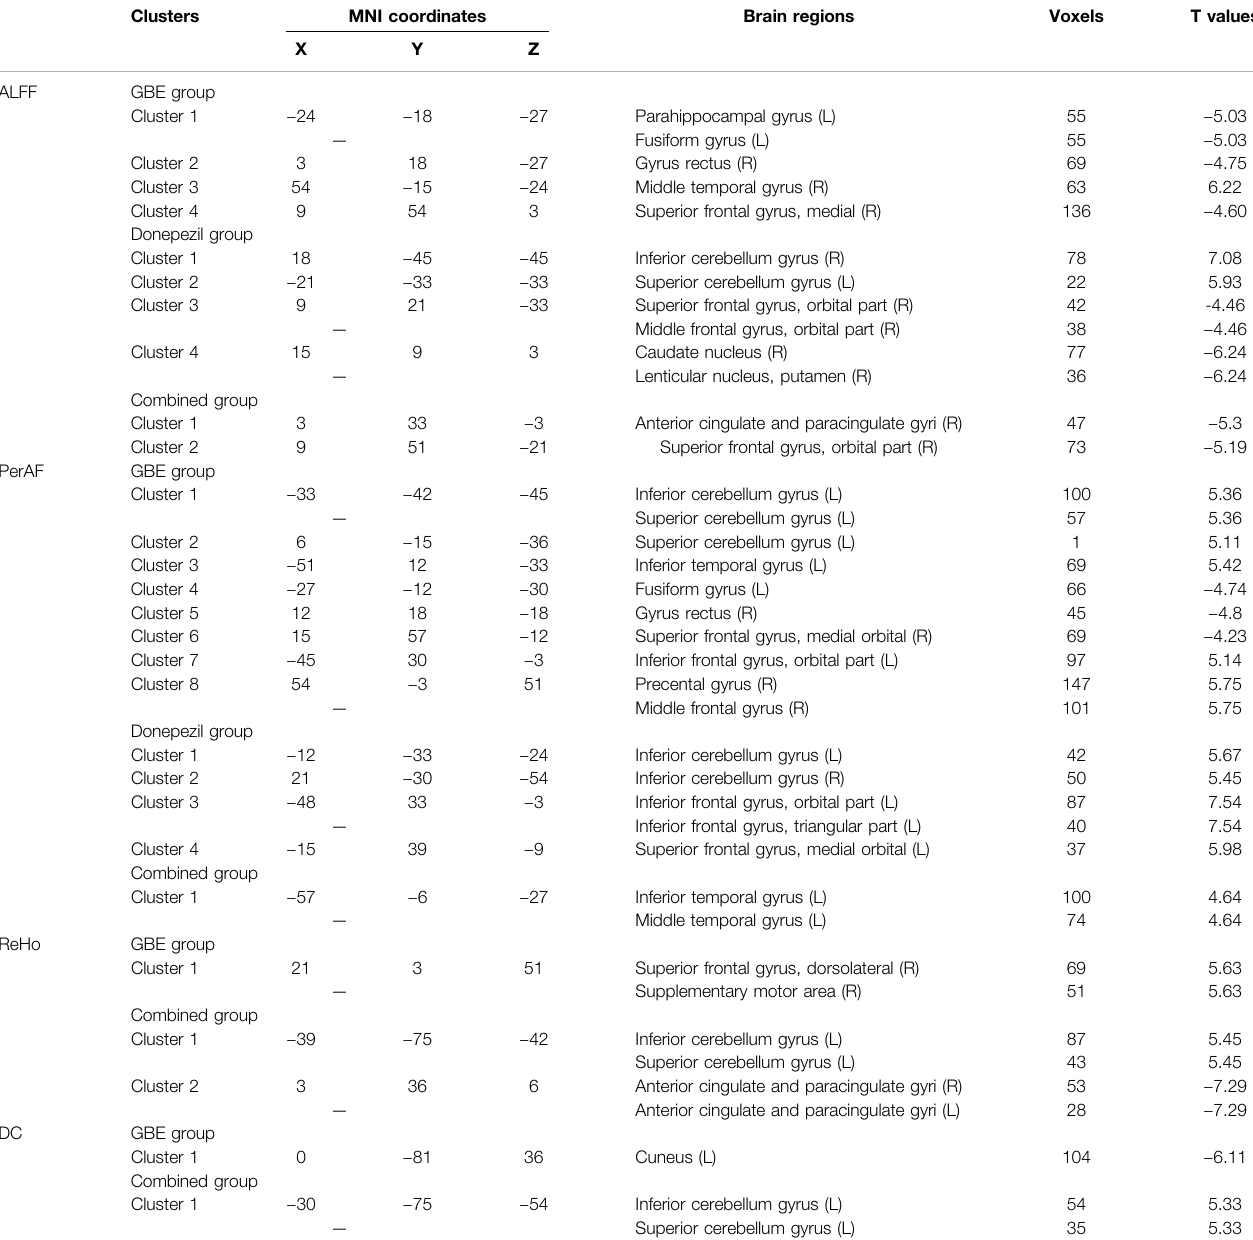
TABLE 6 | Brain regions with signi fi cant different values of ALFF, PerAF, ReHo, and DC of three groups before and after pharmacologic treatment. Clusters MNI coordinates Brain regions Voxels